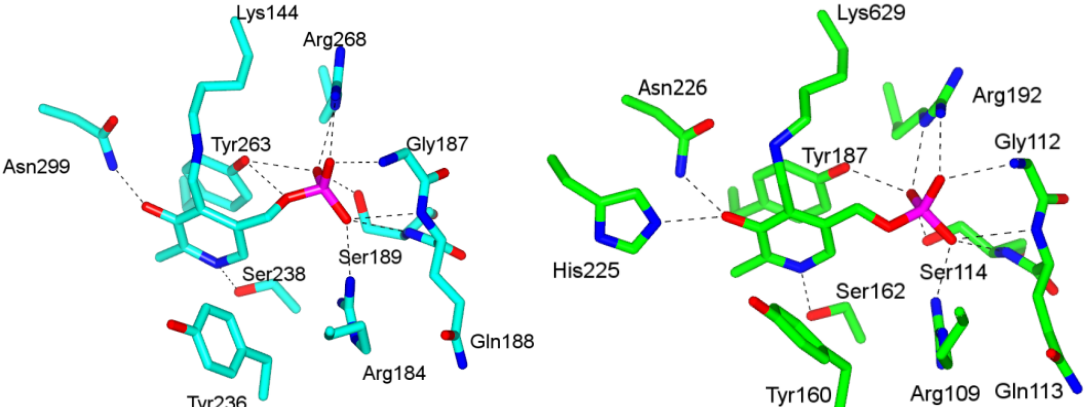
Figure 2. Binding sites of PLP in ( left ) 5,6-LAM (PDB accession code: 1XRS) and ( right ) 4,5-OAM (PDB accession code: 3KP1). These figures were generated using CCP4MG Version 2.7.3.